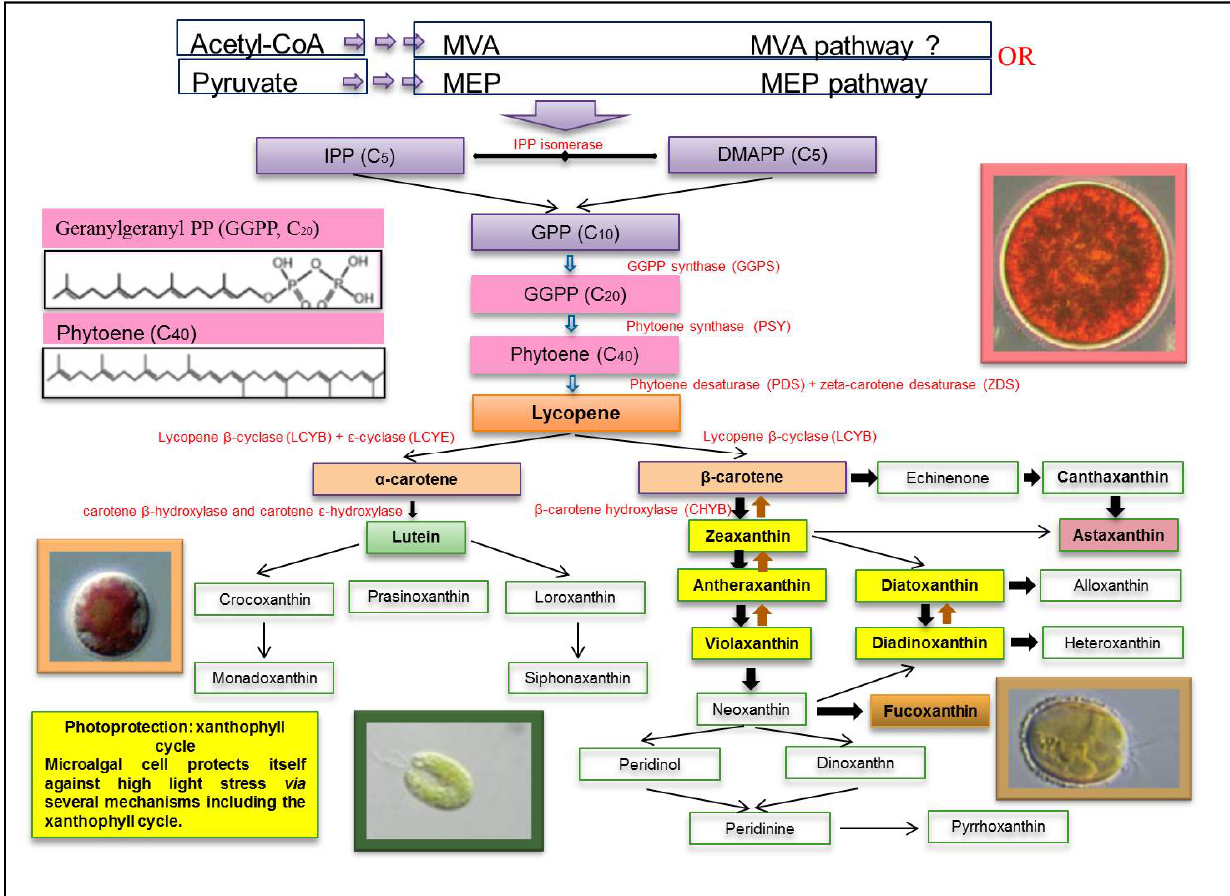
Figure 1. General pattern of xanthophylls synthesis in microalgae. The implicated enzymes in each step of biochemical conversion are listed in red. Their corresponding genes are noted in parentheses. The microalgae Porphyridium sp. (orange border), Tetraselmis sp. (green border), Pleurochrysis (brown border) and Haemotococcus sp. (pink border) are presented as principal producers of β-carotene, lutein, fucoxanthin and ASX, respectively.